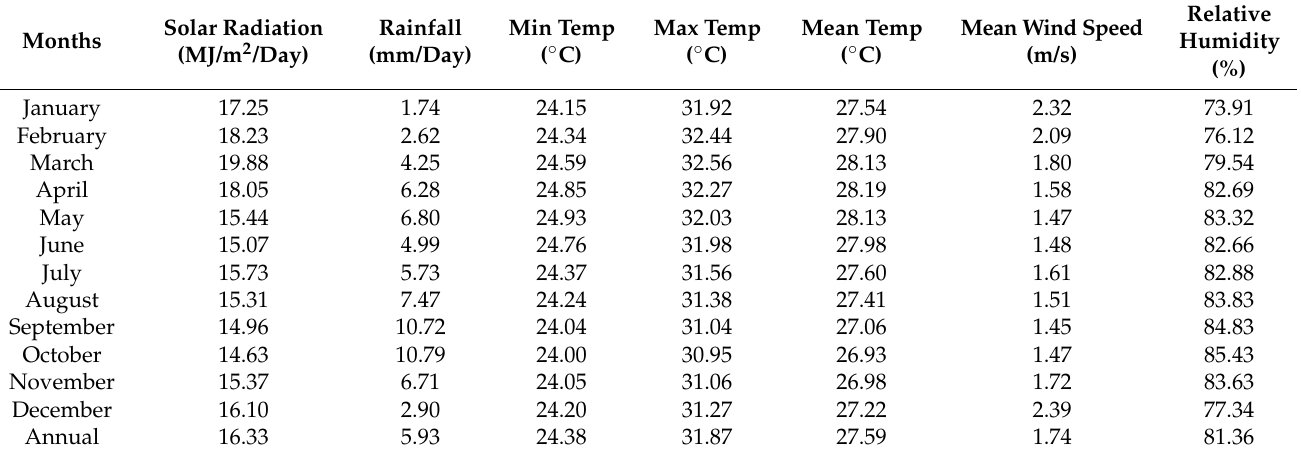
Table 2. The climate information of the study area, based on the ground measured data, Bayan Lepas Meteorological Station (monthly average of the period 1990–2020).